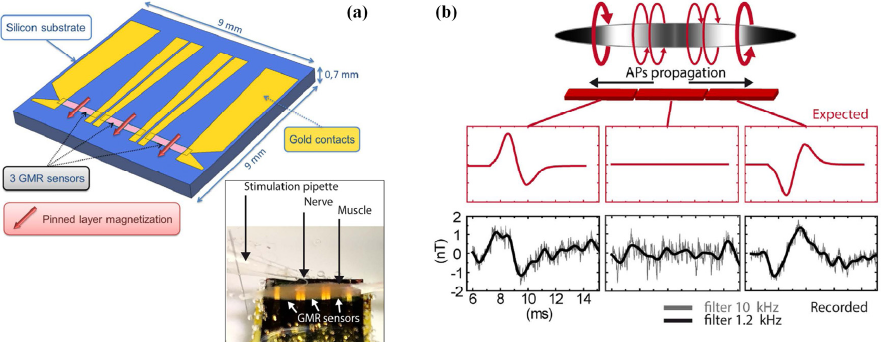
Figure 15. ( a ) Photography of the recording chamber and GMR sensor configuration; ( b ) Expected and recorded simultaneous magnetic signal on the three GMR-sensor derived from active potential after electrical stimulation of the nerve